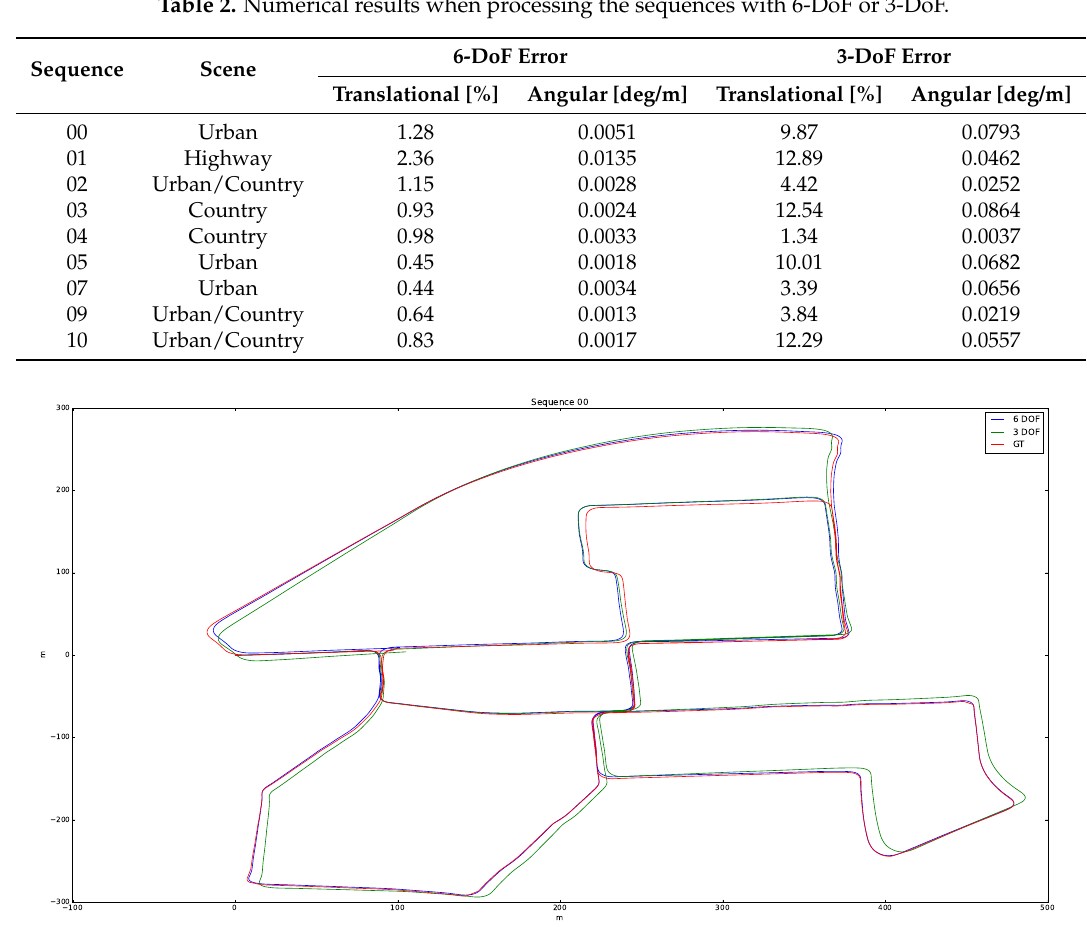
Figure 19. Visual results comparison using the 6-DoF and 3-DoF models in sequence